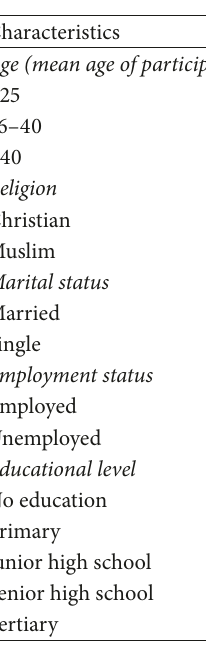
Table 1: Background characteristics of expectant